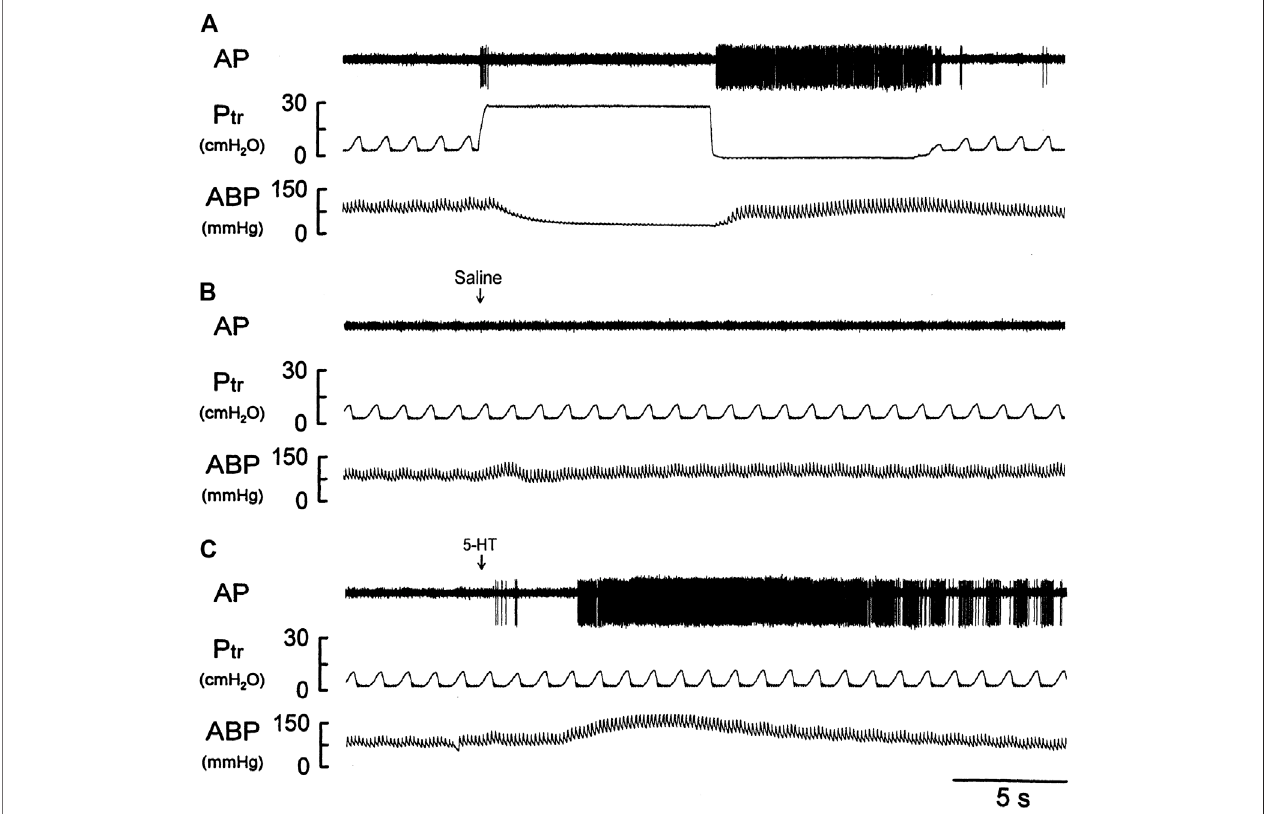
FIGURE 4 | Experimental records illustrating the responses of a silent RAR located in the right middle lobe to (A) a constant-pressure lung hyperin fl ation (P tr = 30 cmH 2 O)maintainedfor10 sandfollowedbylungde fl ation(P tr =0cmH 2 O)for10 s; (B,C) i.v.bolusinjectionofvehicle(isotonicsaline)and5-HT(16 μ g/kg),respectively, in an anesthetized, vagotomized, open-chest, and mechanically ventilated rat (375 g). See the legend of Figure 1 for detailed explanations.